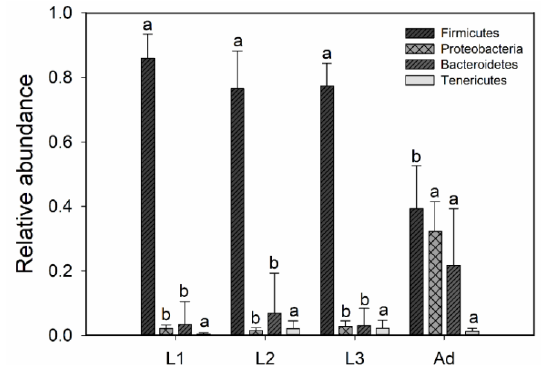
Figure 5. Relative abundance of bacterial taxa at phylum in the gut of different life stages of P. muelleri .